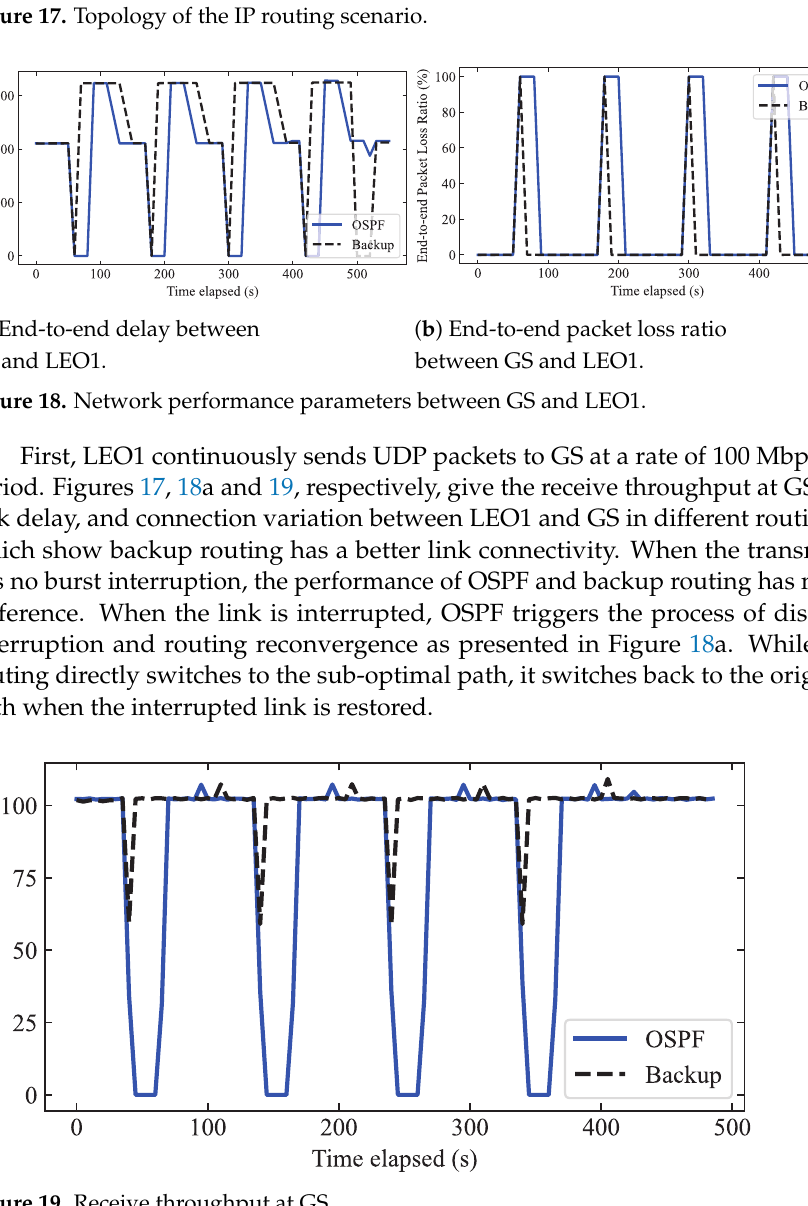
Figure 19. Receive throughput at